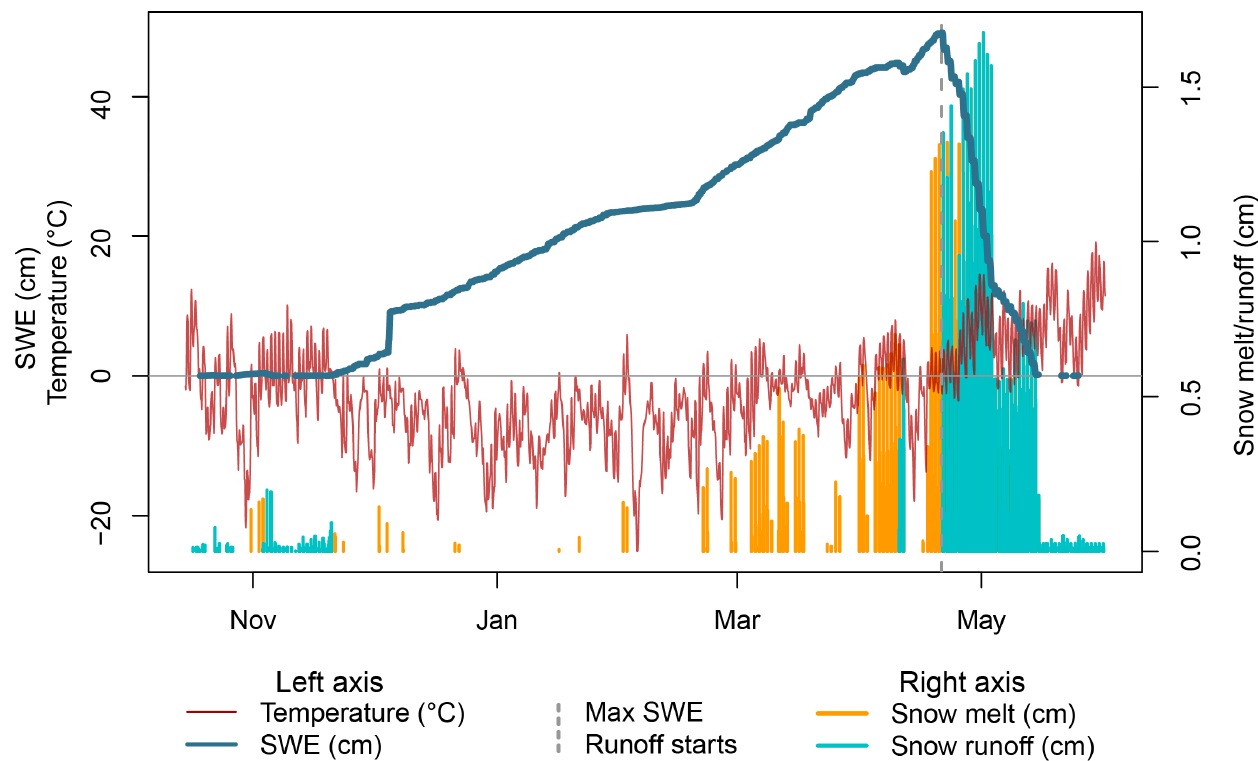
Figure 6. SnowModel calculated air temperature and SWE ( left axis), melt, and runoff ( right axis) at the Mesa West Pathfinder study site (Figure 1, yellow) on the northwestern lobe of Grand Mesa.